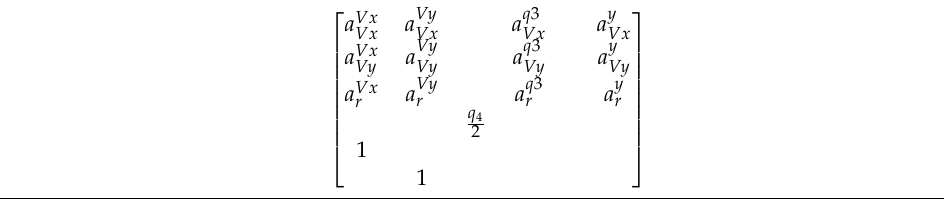
Table 1. Stability matrix for longitudinal motion A .